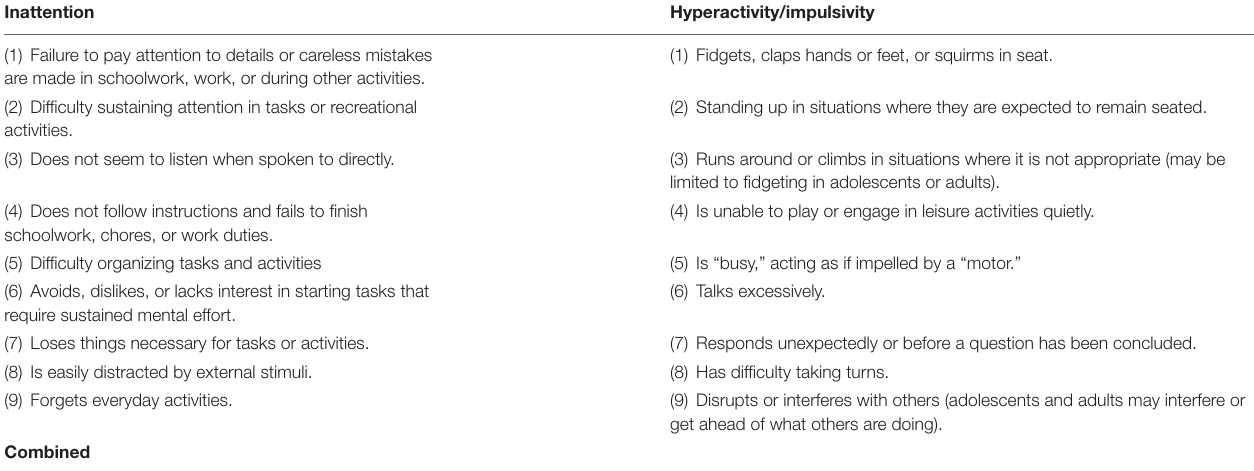
TABLE 1 | Summary of criteria and specific symptoms for the diagnosis of ADHD (American Psychiatric Association [APA], 2013). Inattention